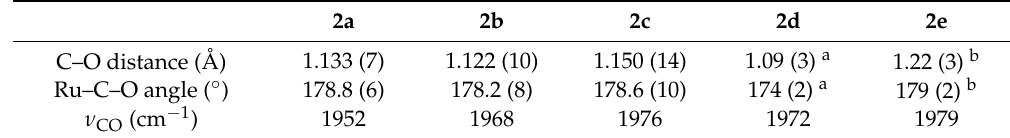
a Data is displayed for one of two molecules. b Data is displayed for one of three molecules.